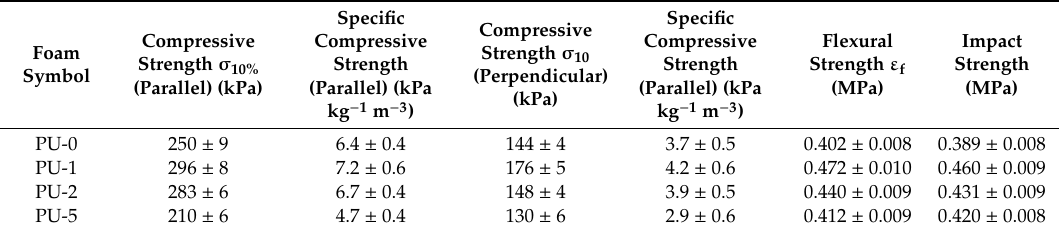
Table 4. Compressive strength, flexural strength, and elongation of PU composite